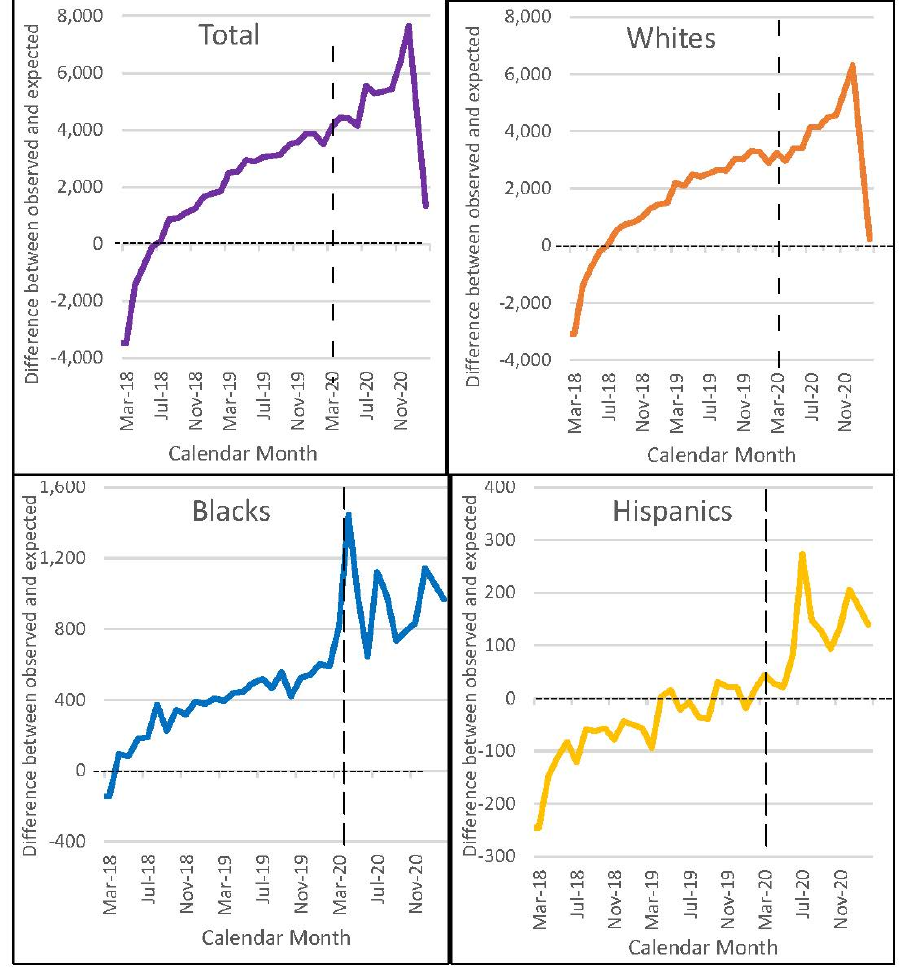
Figure 2. Excess of all-cause monthly deaths as a difference between observed and expected monthly death counts, standardizing by age and gender, among VA users aged 45 years or older by racial/ethnic group from March 2018 to February 2021.